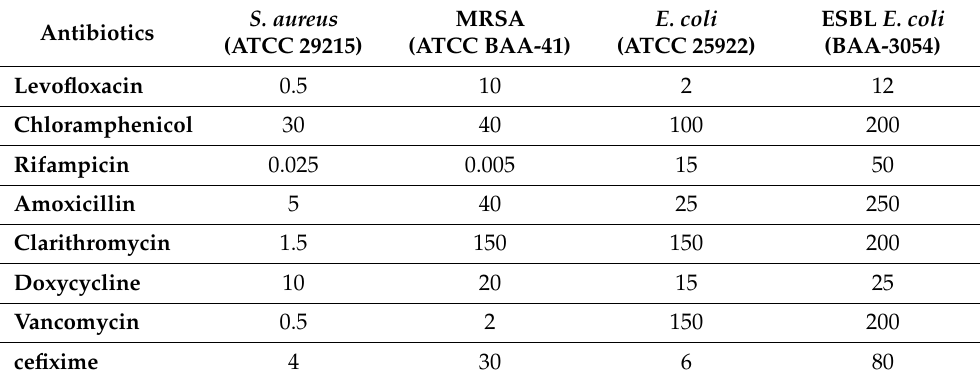
Table 4. Minimum bactericidal concentrations in µ M of the antibiotics against the tested bacte- rial strains.